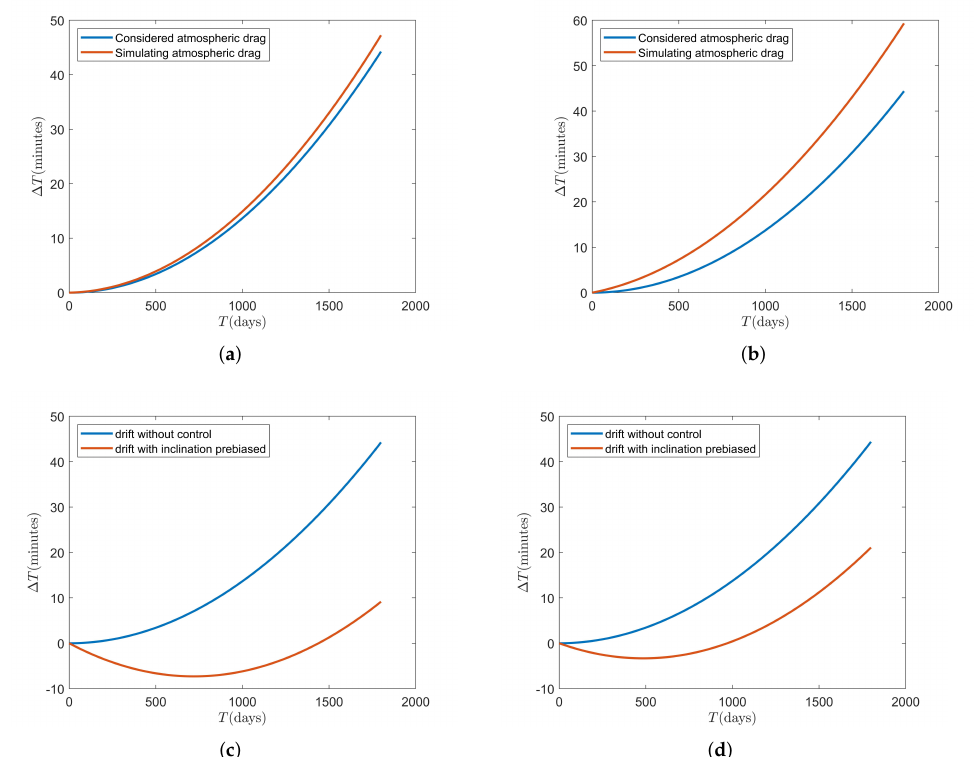
Figure 3. A comparison between ∆ T considered atmospheric drag and ∆ ˜ T simulating the atmospheric drag in 5 Earth years ( a ) ∆ a 0 = 1 km, ∆ i 0 = 1 × 10 − 5 deg, − ( β s − Ω ) = − 135 deg; ( b ) ∆ a 0 = 1 km, ∆ i = 1 × 10 − 4 deg, − ( β s − Ω ) = − 135 deg. A comparison between ∆ T considered atmospheric 0 drag and ∆ ˜ T simulating the atmospheric drag with a prebiased initial inclination in 5 Earth years ( c ) ∆ a 0 = 1 km, ∆ i 0 = 1 × 10 − 5 deg, − ( β s − Ω ) = − 135 deg; ( d ) ∆ a 0 = 1 km, ∆ i 0 = 1 × 10 − 4 deg, − ( β s − Ω ) = − 135 deg.